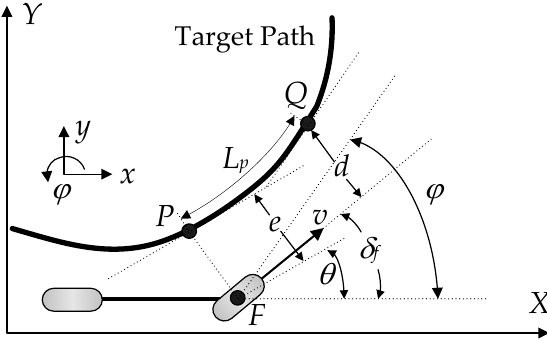
Figure 2. Target path and dynamic variables used for the Stanley method.